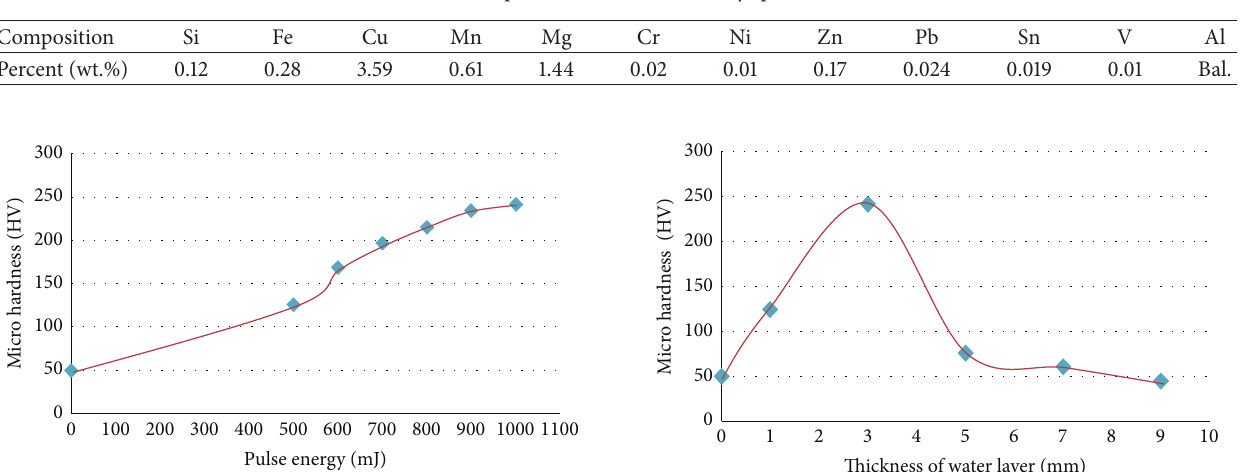
Table 2: Composition of aluminum alloy specimens.